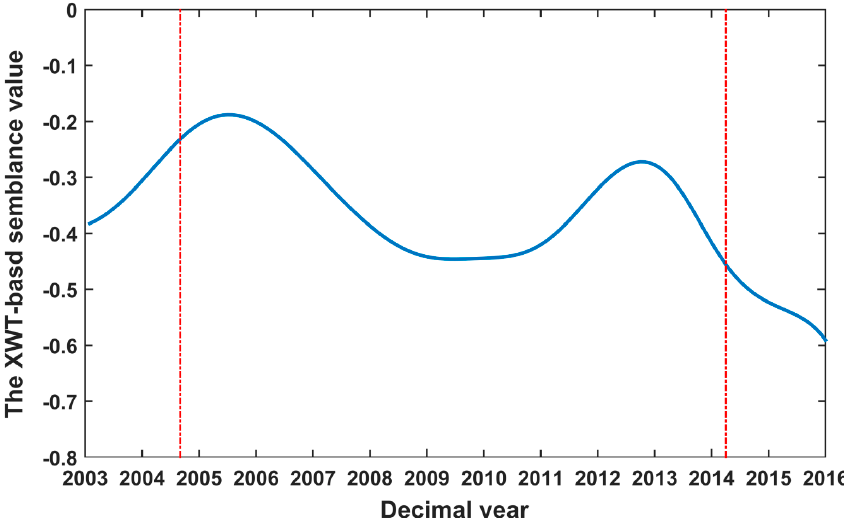
Figure 10. XWT-based semblance value is the closest to one cpy outside the COI. Red dashed lines represent the COI, which limits the region not affected by edge effects.